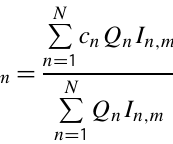
Fig. 11. Scenario with pumping equal to 50m 3 d − 1 with well density of 0.625wellha − 1